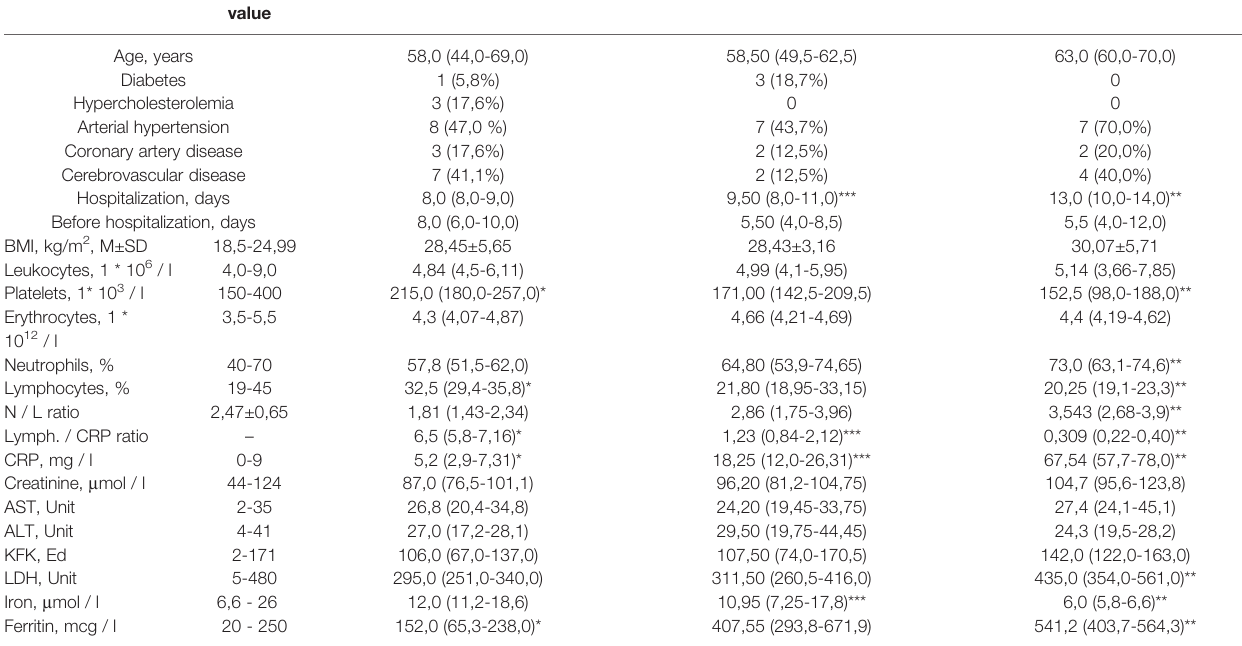
TABLE 2 | Clinical and laboratory characteristics of COVID-19 patients divided into 3 groups according to the CRP levels.